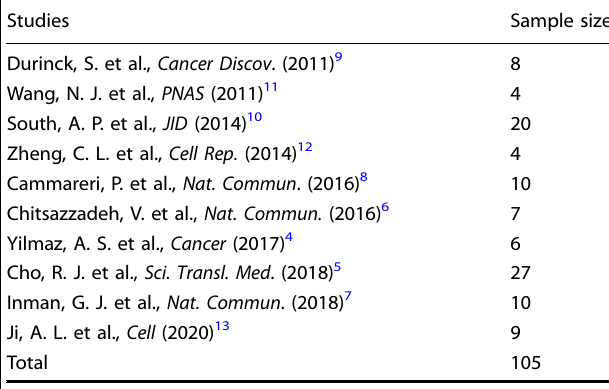
Table 1. Summary of exome or genome sequencing studies analyzed in this